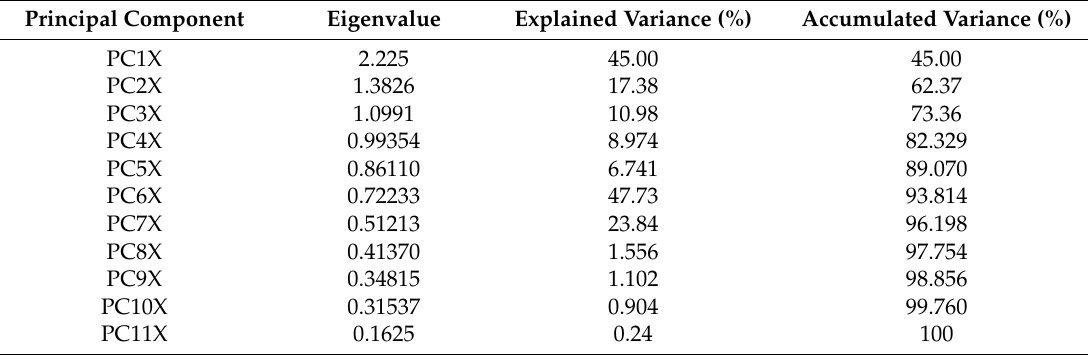
Table 5. Percentage of variance of the eleven PCs related to input load.